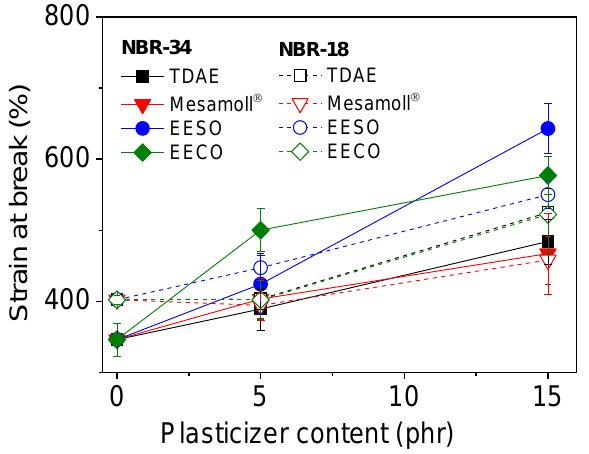
Figure 5. Variation of strain at the break with plasticizer content for NBR vulcanizates.